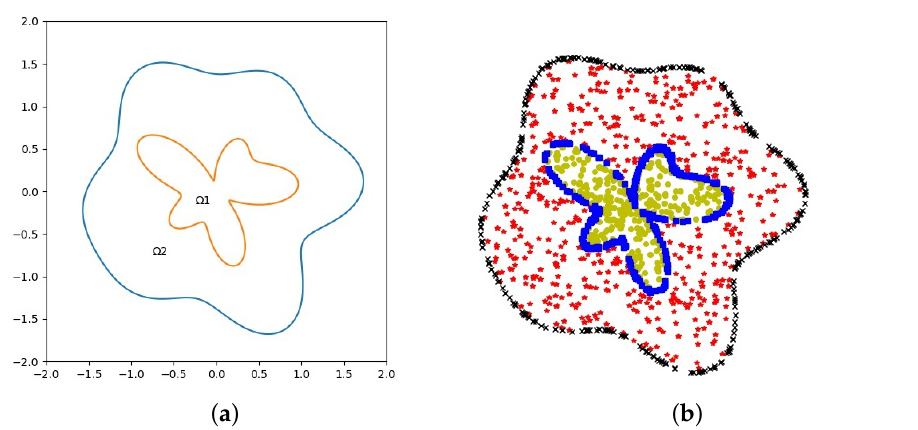
Figure 11. ( a ) Computational domain and interface shape and ( b ) training points.